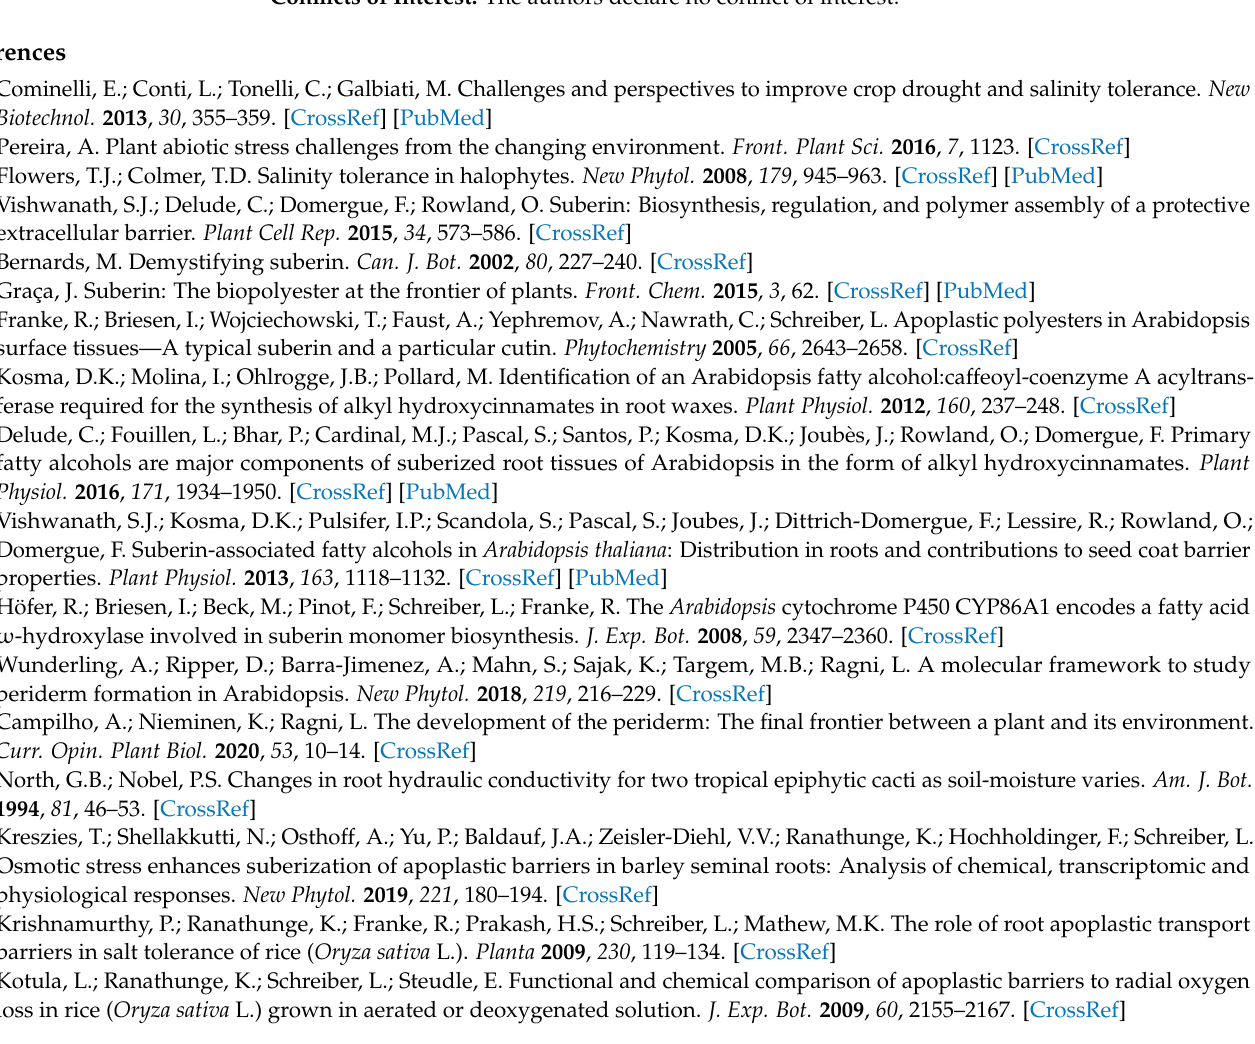
treatment, Figure S8: Segregation of leaf ionomic phenotypes in wild-type and mutants by Principal Component Analysis (PCA), Figure S9: Mature Arabidopsis root at the stage of chemical and electron microscopic analyses, Table S1: ANOVA statistical test of the drought stress experiment, Table S2: ANOVA results of the salt stress experiment, Table S3: Primers used for PCR genotyping, Table S4: Data from ICP-MS analysis of elements in leaf tissues, Table S5: Results of the Kruskal-Wallis test investigating genotypic effect for leaf micronutrient